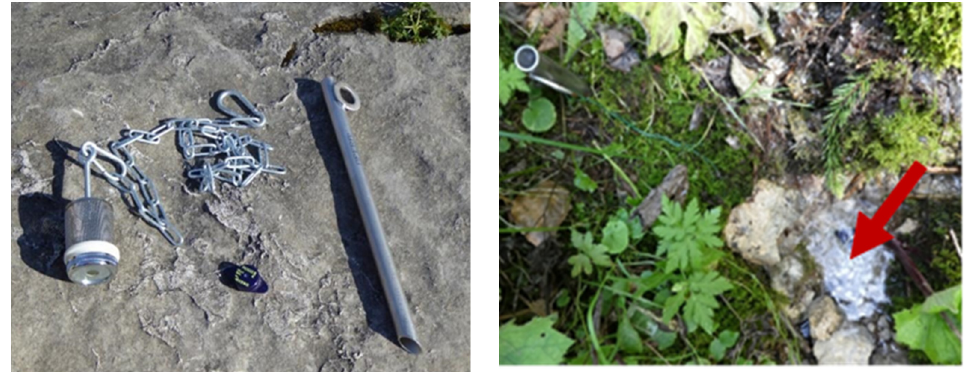
Figure 5. Metal rod, chain and metal basket to fix and protect the data logger against bed load ( left ). Attachment of a data logger in a spring ( right ).